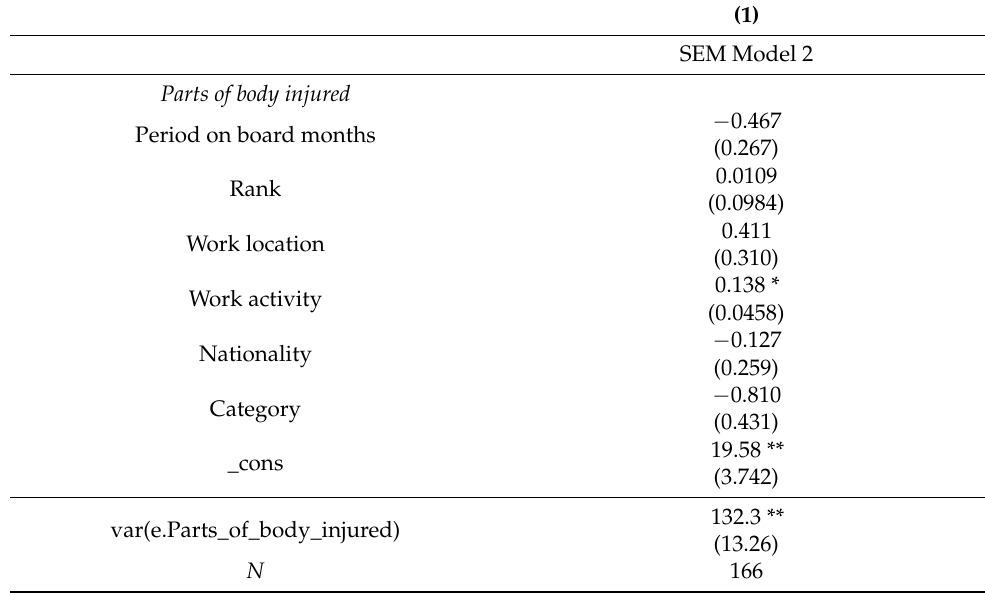
Table 5. Detailed results of SEM 2—second model of structural equation modeling.